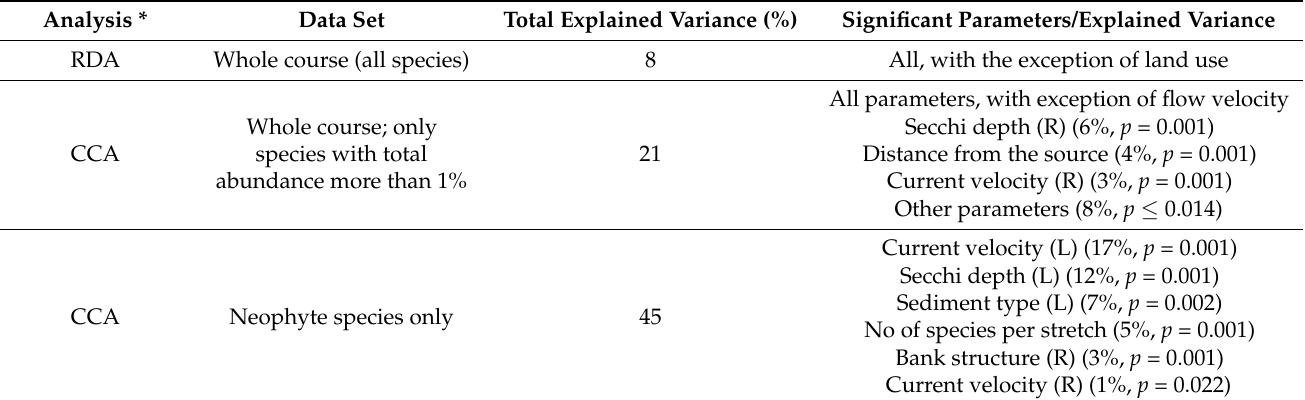
Table 2. Summary of multivariate analyses aimed to explain the species presence and abundance with environmental selected environmental parameters. RDA—Redundancy analysis, CCA—Canonical correspondence analysis, DCA— Detrended correspondence